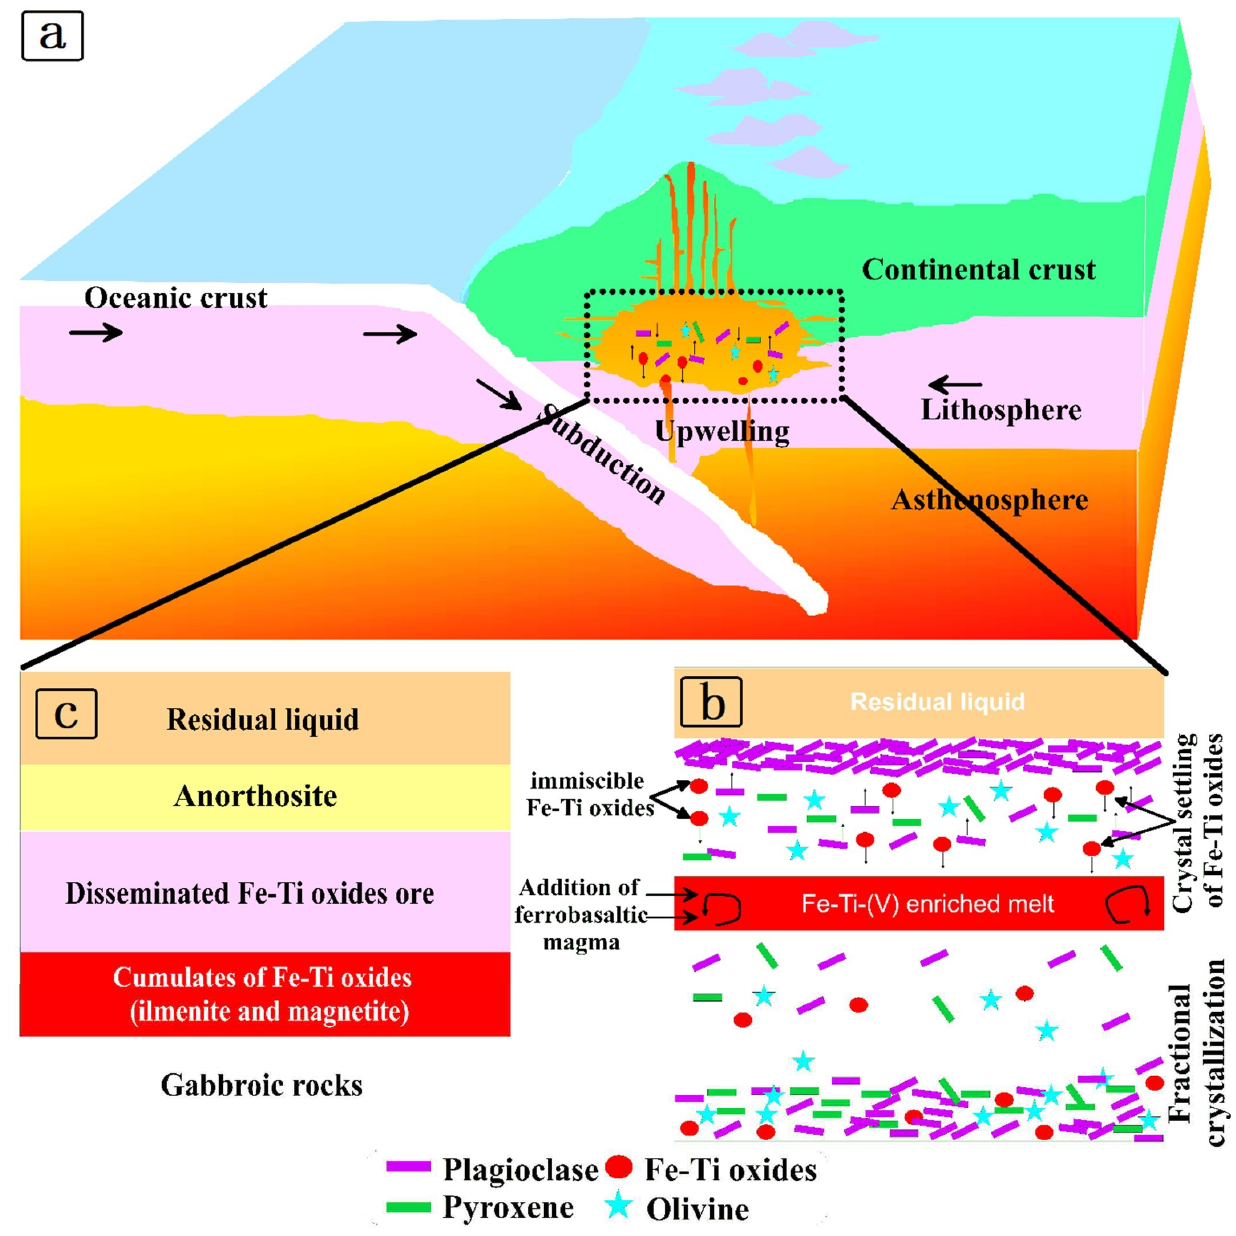
Figure 14. Petrogenetic model for Fe-Ti oxide ores modified after [3,52], accomplished with the Abu Ghalaga intrusion, showing the following: ( a ) subduction zone showing oceanic crust beneath the continental crust; ( b ) fractional crystallization of magma accompanied by crystal settling of Fe-Ti oxide crystals; ( c ) the production of significant Fe-Ti oxide ores caused by the concentration of Fe-Ti oxide crystals following the crystallization of Fe-Ti-(V)-enriched liquids with ferrobasaltic